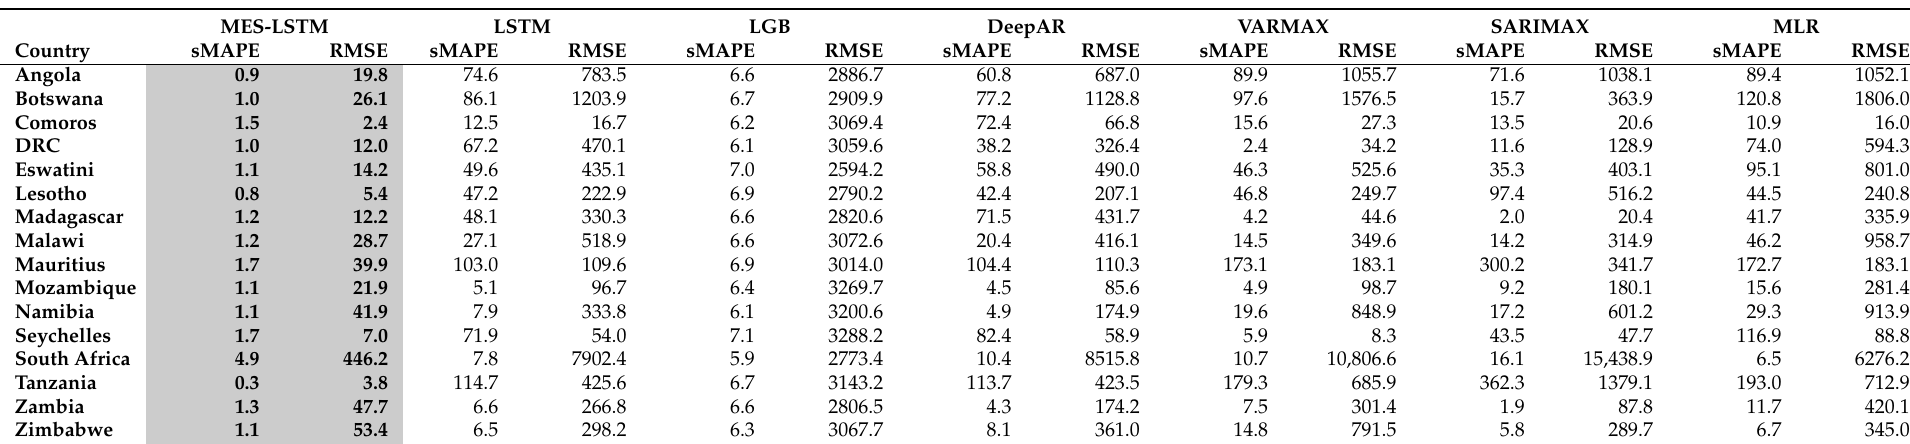
Table 5. Forecast Accuracy Averaged Over All Trials for total deaths in the SADC